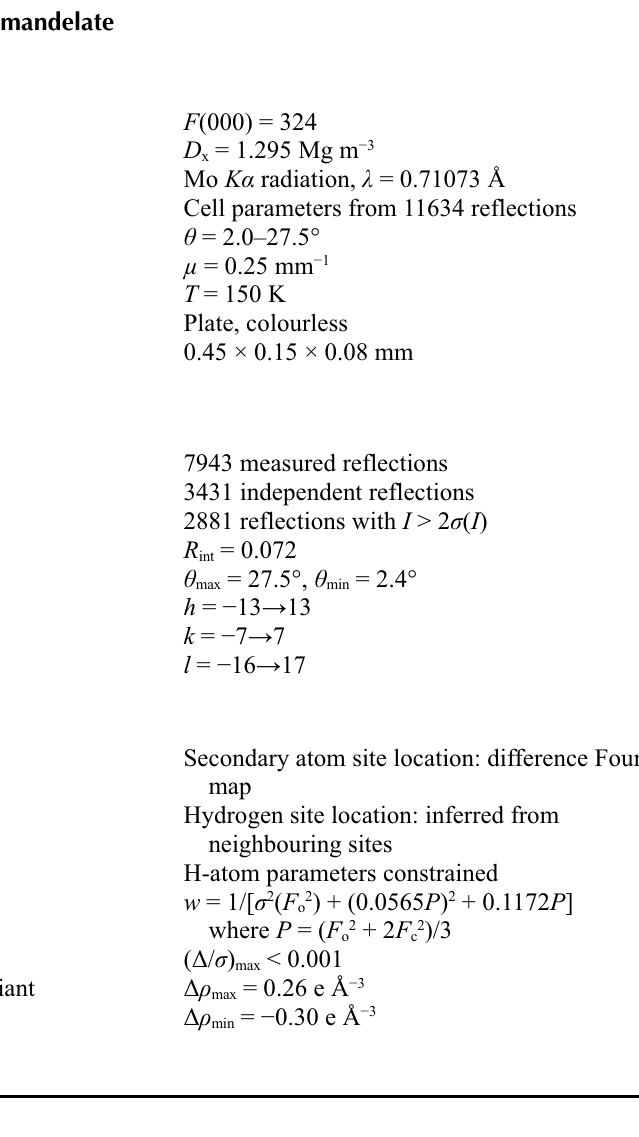
Figure 1 The molecular structure of the title compound with 30% probability displacement ellipsoids and the atom labelling